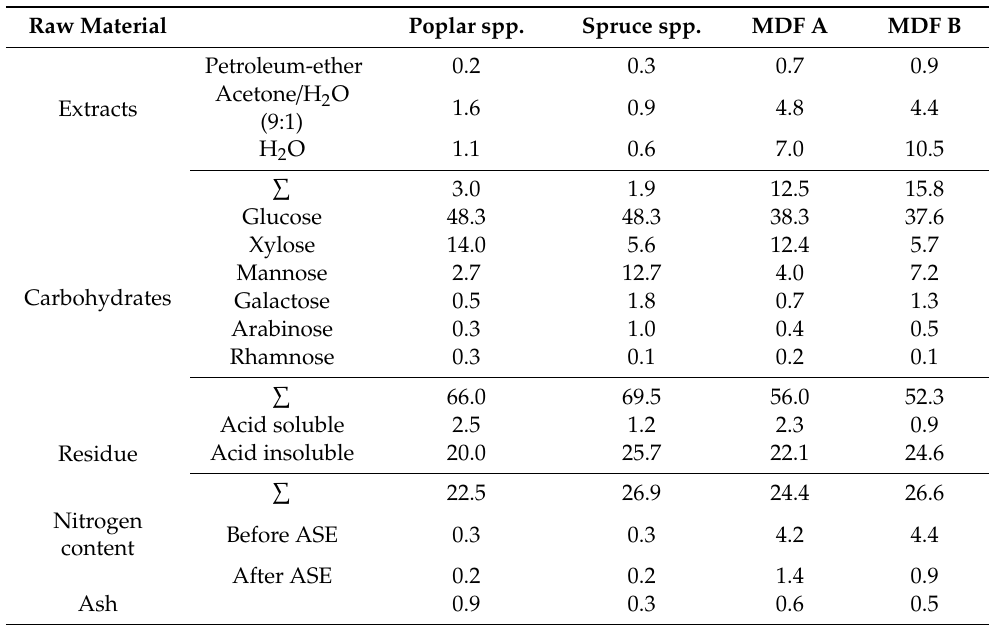
Table 2. Extract, carbohydrate, lignin, nitrogen, and ash contents of poplar, spruce, and medium-density fiberboard (MDF) sample A and B in [%] based on raw material. Raw Material Poplar spp. Spruce